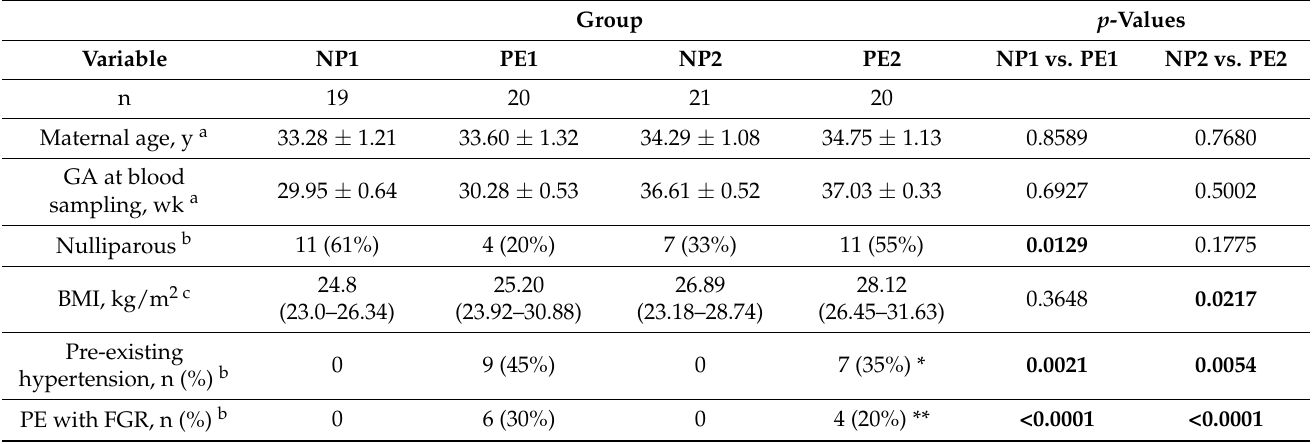
Table 1. Clinical characteristics of patients included in the